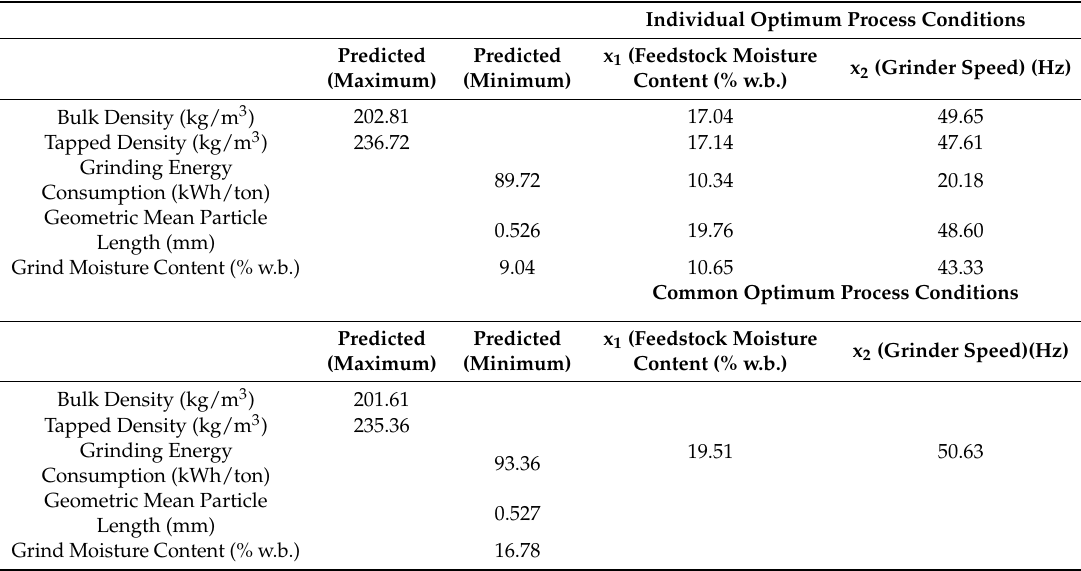
Table 6. The optimized process conditions obtained using a hybrid genetic algorithm